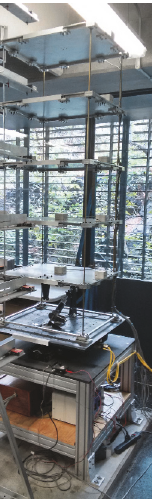
Figure 2: Experimental structure.